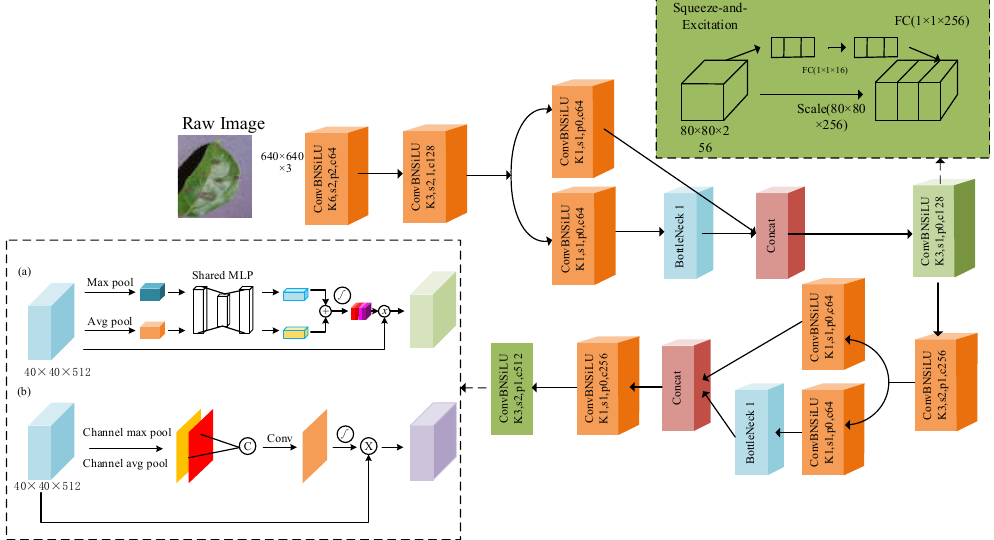
Figure 2. The CSPNet neural network structure of dual-attention mechanism. The size of the feature image F 80 × 80 × 256 after feature fusion was 1 × 1 × 256 after channel information was processed using an 80 × 80 average pooling operation. Thereafter, based on a full connection layer composed of 16 neurons, a 1 × 1 convolution rectified linear unit (ReLU) of activation function and a full connection layer composed of 256 neurons and a 1 × 1 convolution sigmoid of activation function features were assigned weight values between 0 and 1 to obtain the final feature image F 1 × 1 × 256 . The final channel number was calculated using Formulas (1) to (3) [22].